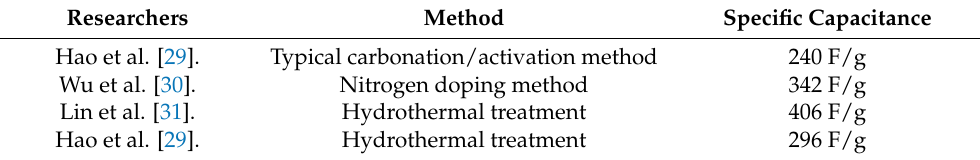
Table 2. Research progress and properties of porous carbon structures prepared by WSS. Researchers Method Specific Capacitance Hao et al. [29]. Typical carbonation/activation method 240 F/g Wu et al. [30]. Nitrogen doping method 342 F/g Lin et al. [31]. Hydrothermal treatment 406 F/g Hao et al. [29]. Hydrothermal treatment 296